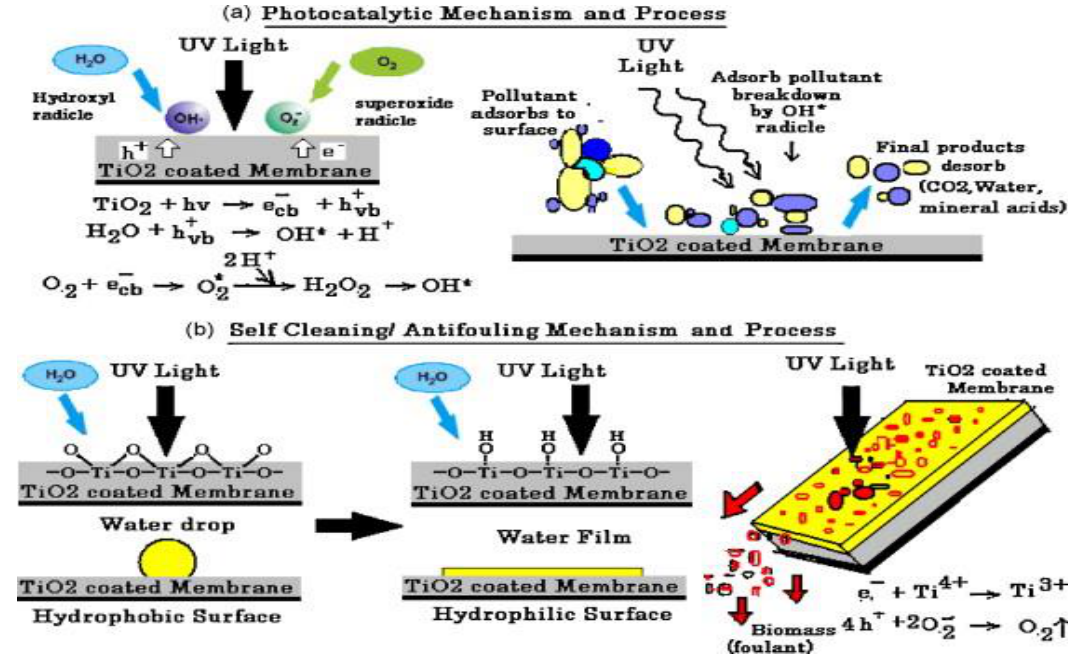
Figure 11. ( a ) Photocatalysis mechanism and process. ( b ) Self-Cleaning/antifouling mechanism and process of polyvinylidene fluoride (PVDF)/TiO 2 membrane. Reproduced form [207].